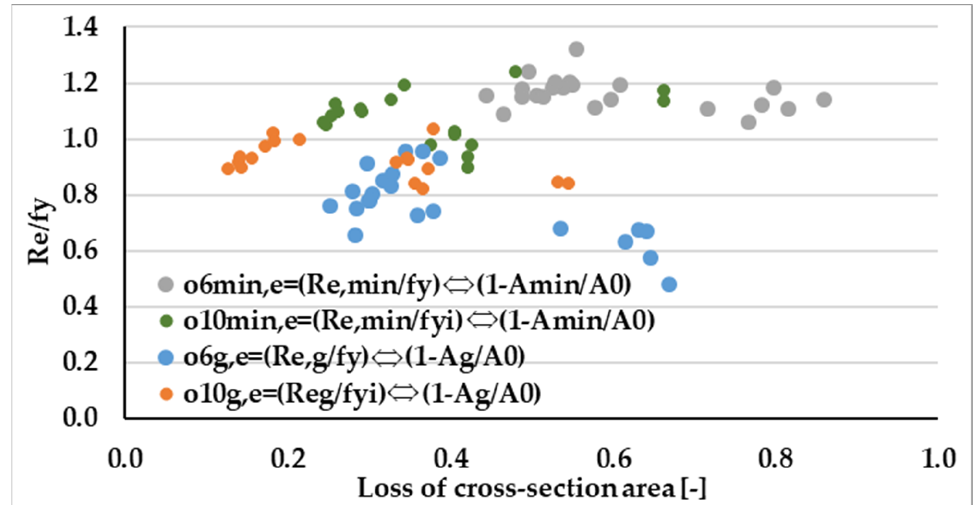
Figure 20. Dependence of the yield strength ratio of the corroded (R e,g /f t ) and non-corroded sample (R e,min /f t ) on the relevant loss of cross-sectional area of reinforcement ((1 − A g /A 0 ) or (1 − A min /A 0 ))— comparison ϕ 6 and ϕ 10.